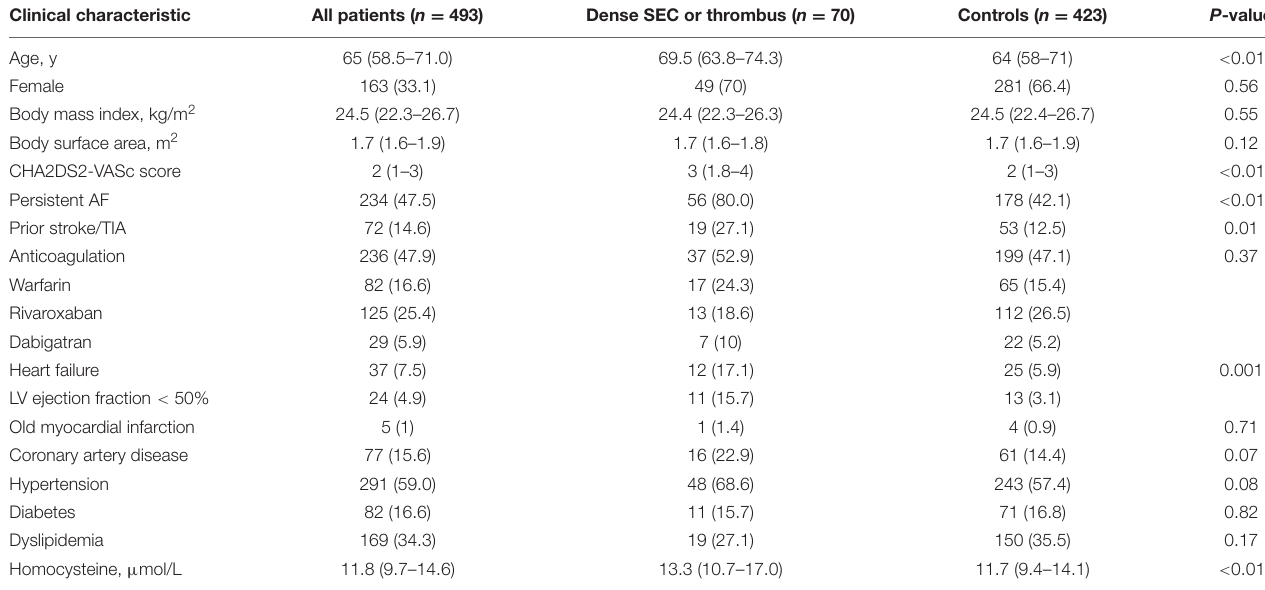
TABLE 1 | Baseline clinical